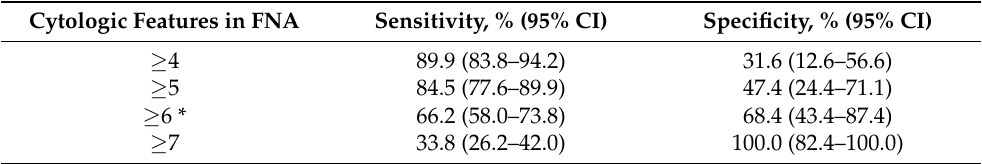
Table 5. Diagnostic property of significant cytologic features in FNA for discriminating accurately categorized or incorrectly categorized